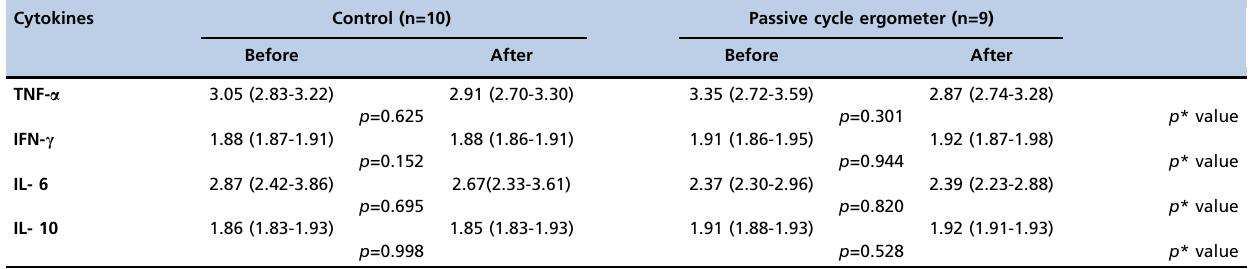
Proinflammatory cytokines (TNF- a , IFN- g and IL-6) and antiinflammatory properties (IL-10). Values written in bold are statistically significant. Data are the median (25 – 75% percentile) before and after testing. *Wilcoxon